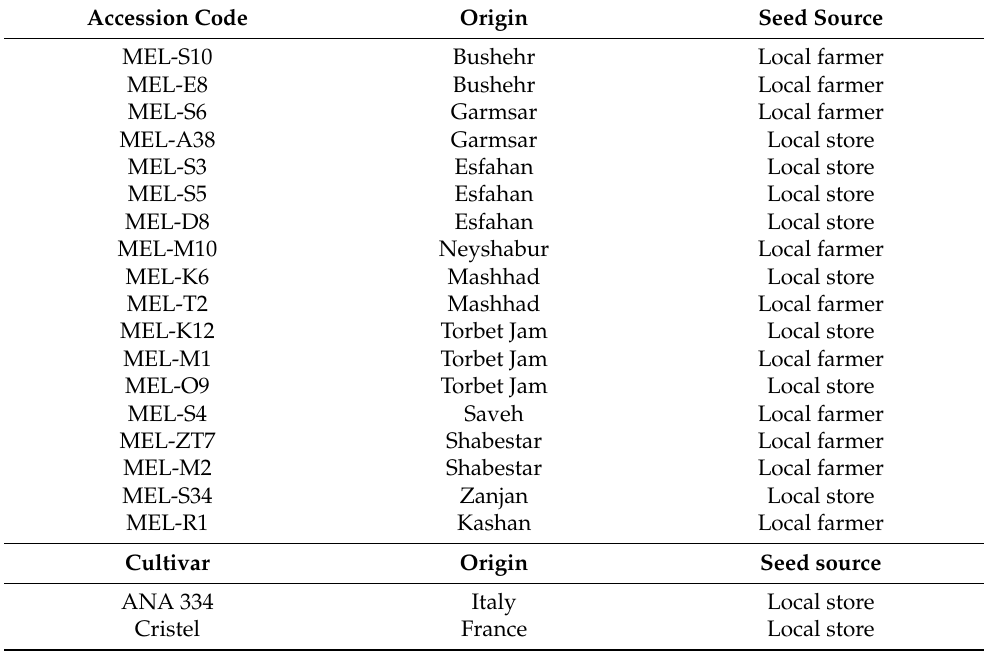
Information about the origin and source of Iranian melon accessions and two commercial